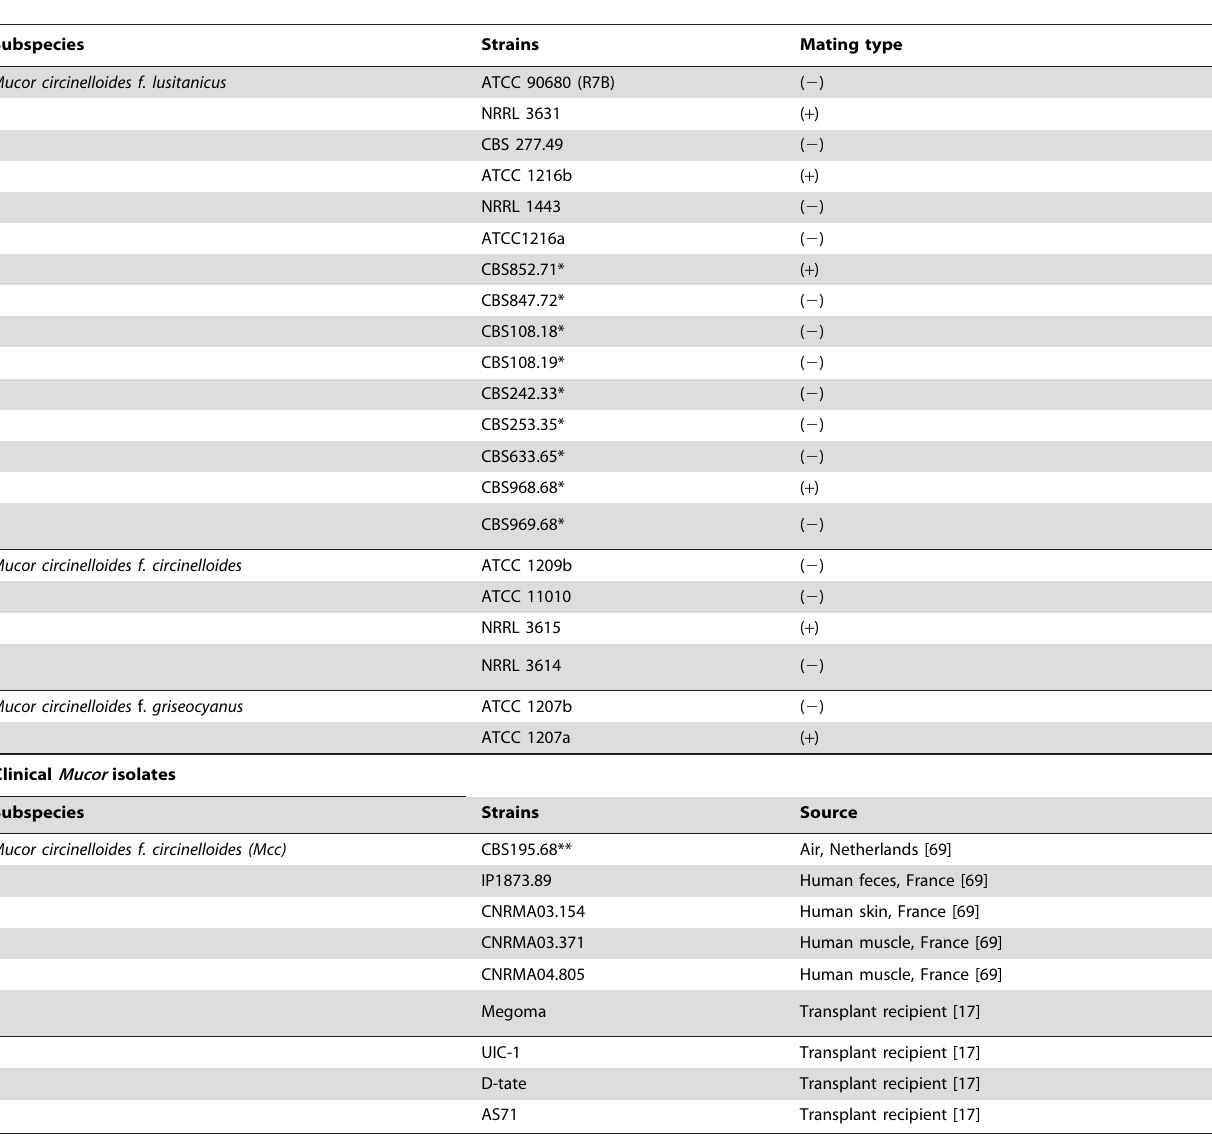
Table 1. Mucor circinelloides strains used in this study.